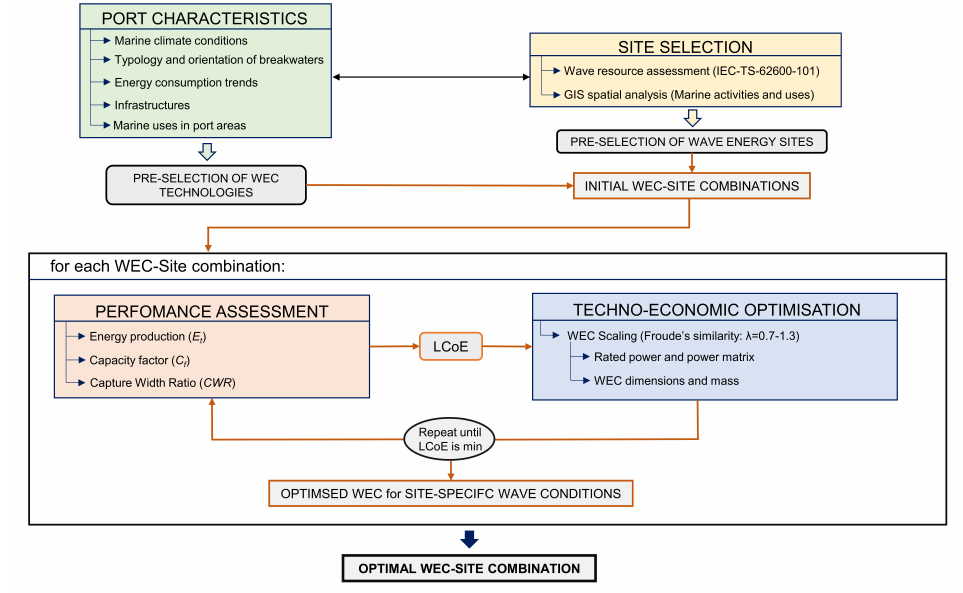
Figure 2. General overview of the integrated methodology to select the optimal WEC-site combination for the energy supply of